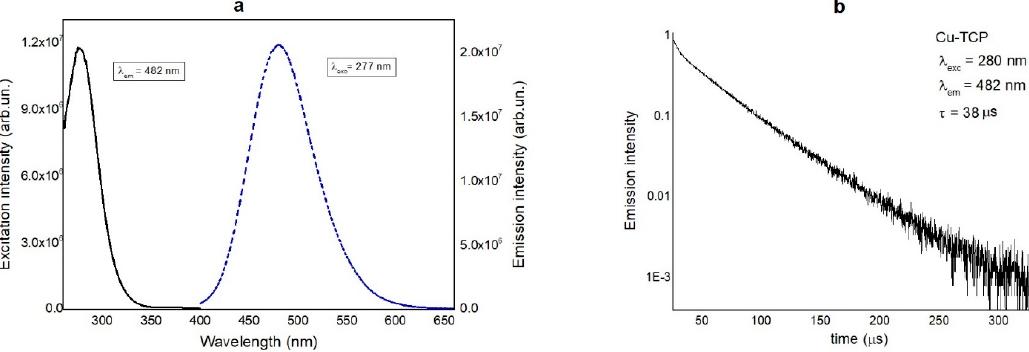
Figure 9. Cu β -TCP structure: Emission/excitation spectra ( a ) and decay time ( b ).